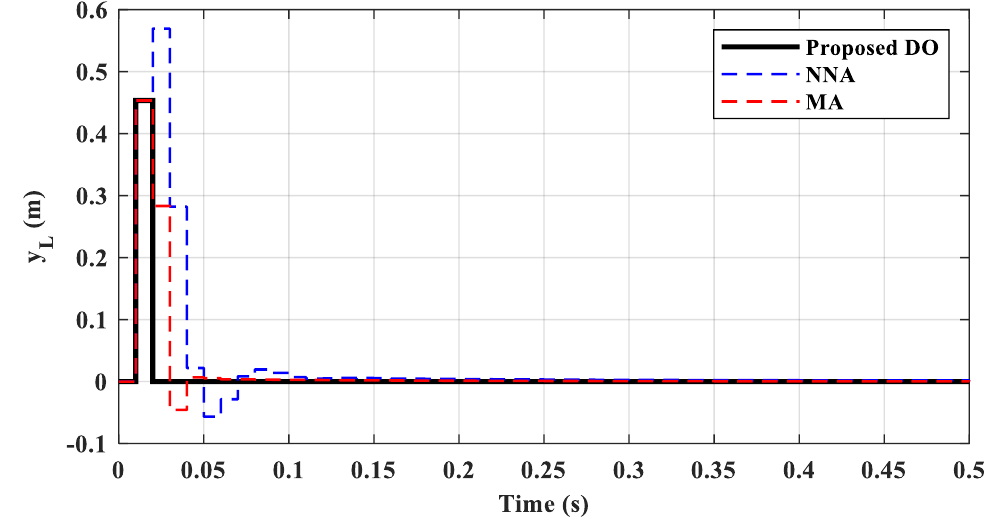
Figure 8. The output response of the AV lateral deviation against 0.3 m − 1 step disturbance in the road curvature.